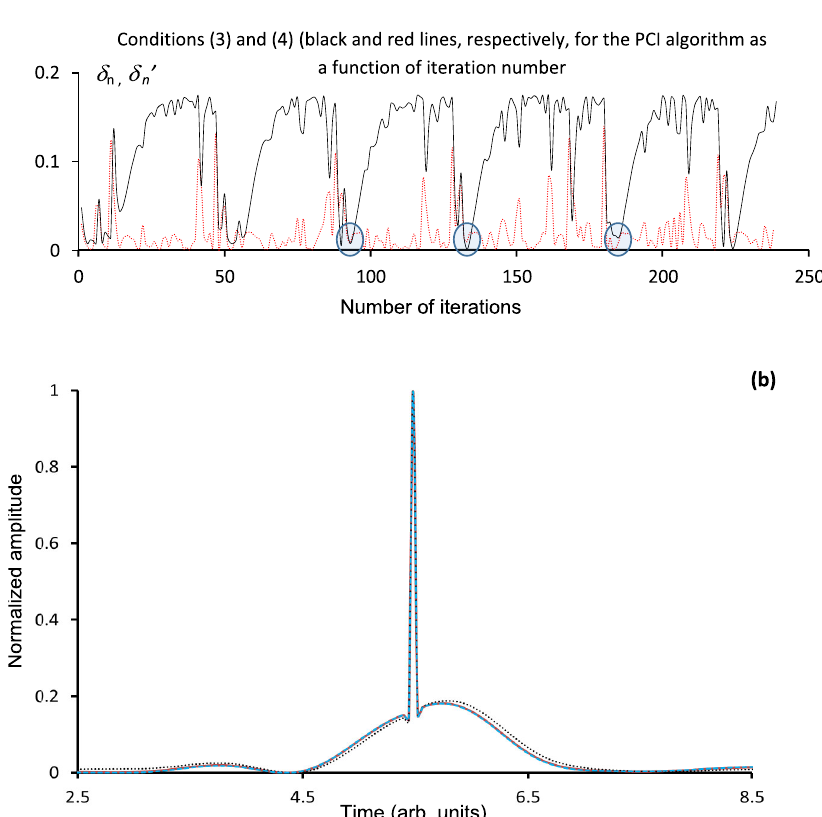
FIG. 4. (a) The values of conditions (3) and (4) as a function of iteration number for the PCI algorithm applied to the profile of Fig. 3. The circled points indicate the iteration number where both conditions are satisfied simultaneously and the process can be stopped. (b) The corresponding time profiles recovered at the end of the